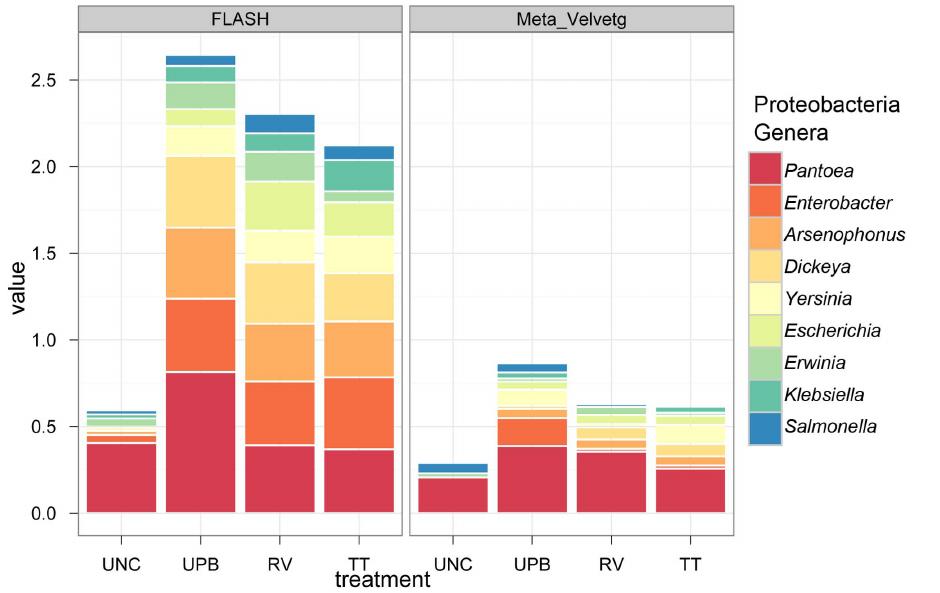
Figure 4. Taxonomic classification of the nine most prevalent Proteobacteria genera in uncultured and cultured samples based on FLASHed and Meta Velvetg assembly and the lowest common ancestor taxonomic rank among the best hits (maximum e-value cutoff of 1.0 2 5 , minimum percent identity of 95%, and minimum alignment length 99 bp).